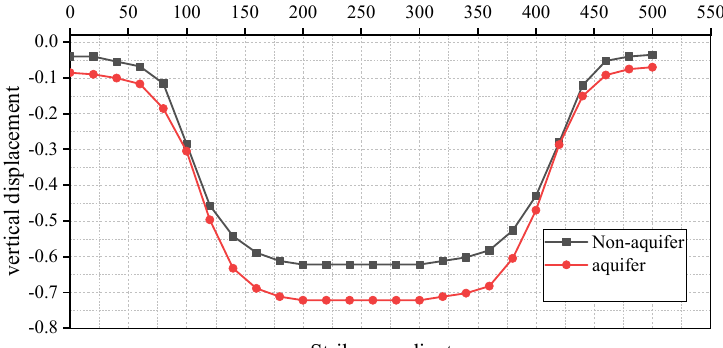
Figure 9. Comparison of surface vertical displacement.